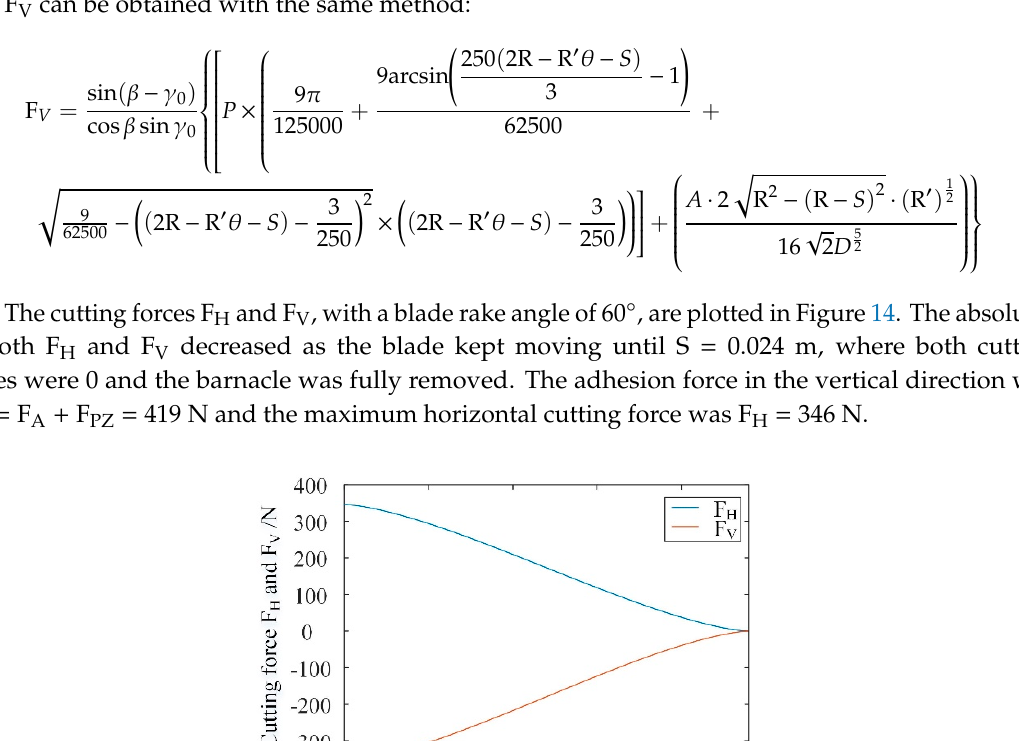
Figure 15. The simulation diagram of barnacle. The adhesion forces of both simulation and analytical results are plotted in Figure 16 with respect to the blade displacement.